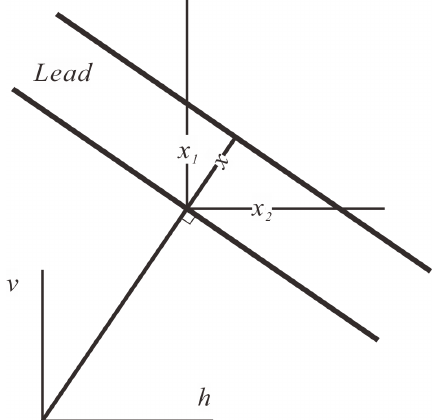
Figure 2. Detection of lead width using two orthogonal directions. x is the real lead width. Lead extents in orthogonal system in v and h directions are measured as x 1 and x 2 ,